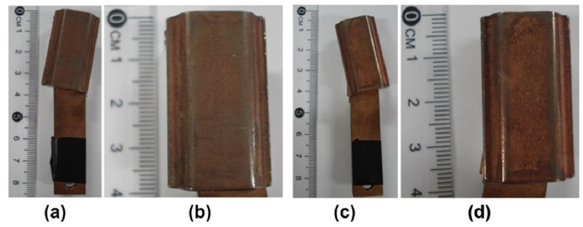
Figure 7. Sample 1: ( a ) whole body, ( b ) measured region; Sample 2: ( c ) whole body, ( d ) measurement region.